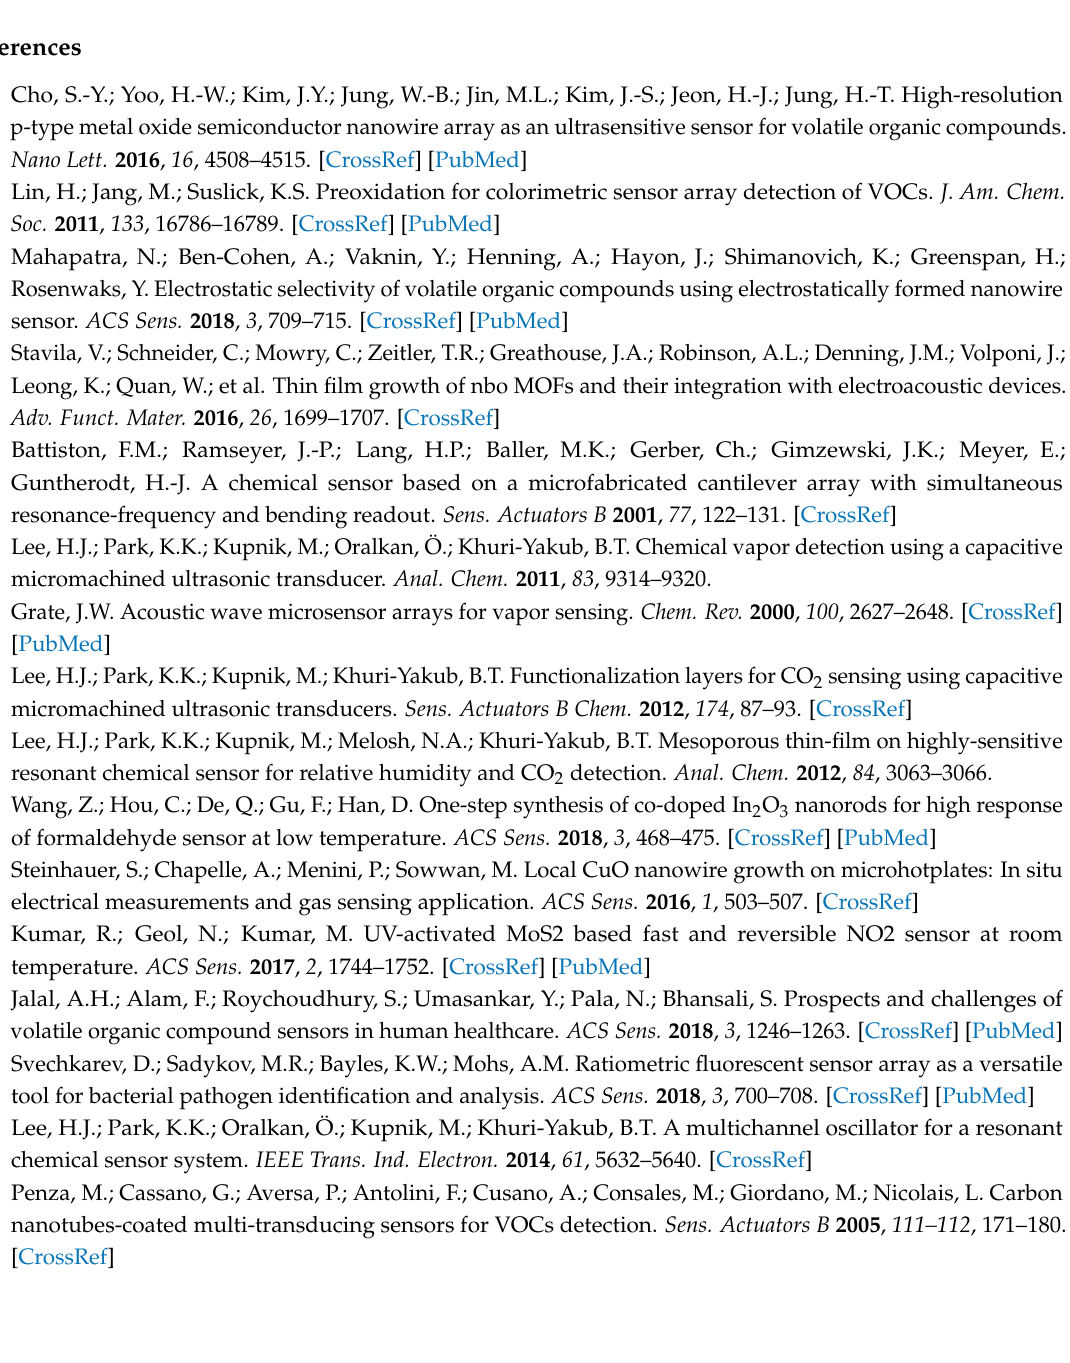
Figure S6. Plot of (a) fall time and (b) rise (or recovery) time calculated from the transient measurements of two sensors (coated with colloid layer and PSAA layer) in response to various concentrations of toluene and ethanol. Author Contributions: I.Y. and G.E. contributed equally. I.Y. and G.E. designed and implemented the sensor system and conducted chemical experiments. S.L. fabricated the sensor device, and B.K. prepared functionalization layer. S.K.K. and H.J.L. conceived and designed the experiments. All authors discussed the results and commented on the